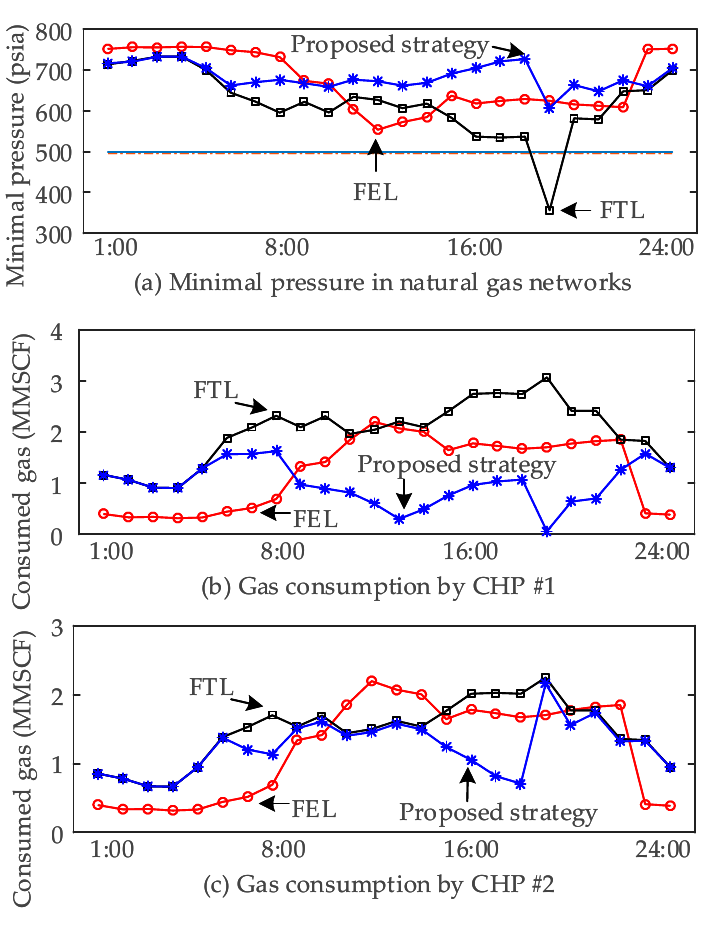
Figure 14. Control performance on the natural gas networks (( a ) Minimal pressure in natural gas networks ( b ) Gas consumption by CHP #1 ( c ) Gas consumption by CHP #2).